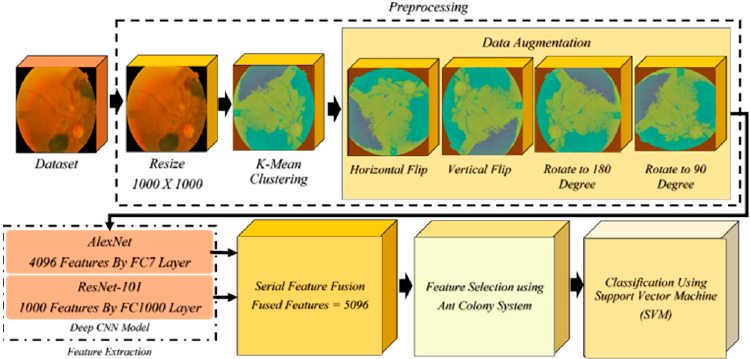
Figure 1. Describes the architecture of proposed